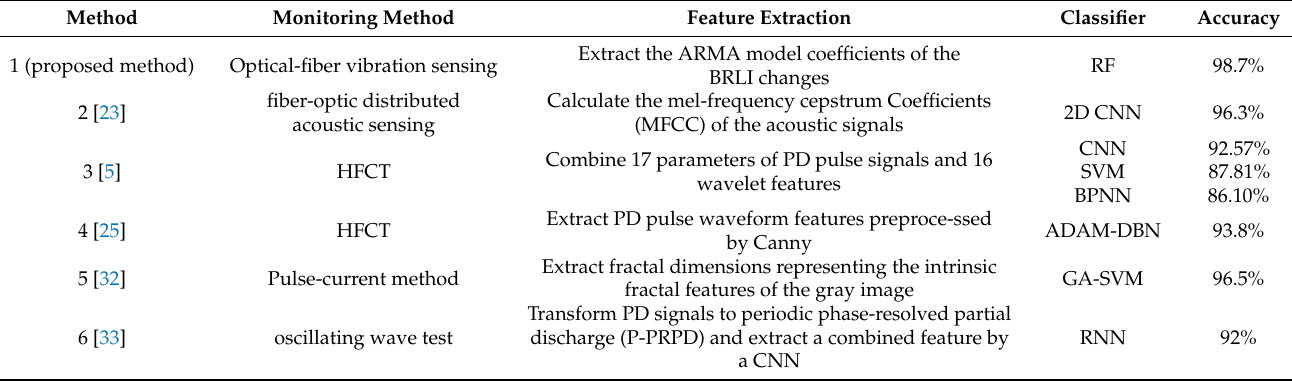
Table 3. Comparison between proposed PD-recognition model and previous methods.